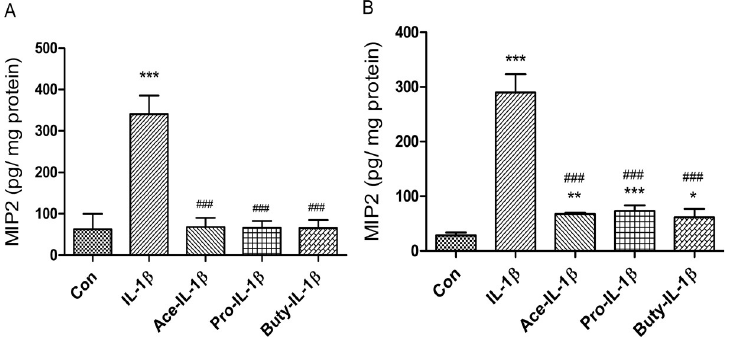
Fig 3. The anti-inflammatory effects of SCFAs on immature enterocytes in ex vivo mouse intestine. Embryonic 18.5day (E 18.5) C57BL6 fetal mouse small ( A ) and large ( B ) intestinal organ culture were pretreated with SCFAs (20 mM for 30 min) before IL-1 β stimulation (1ng/ml for 24h). The secretion of IL-8 into the supernatants was assayed by Elisa. Data are represented as the mean ± SEM of two independent experiments. N = 6 for each experiment. One -way ANOVA and Tukey post hoc tests were used for statistic. Differences compared to the control group were considered significant at �� p < 0.01, ��� p < 0.001; differences compared to the IL-1 β group were considered significant at ### p <